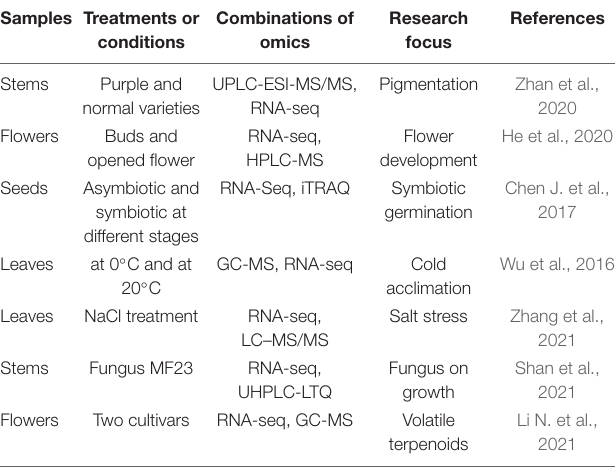
TABLE 4 | A summary of omics integration in D.